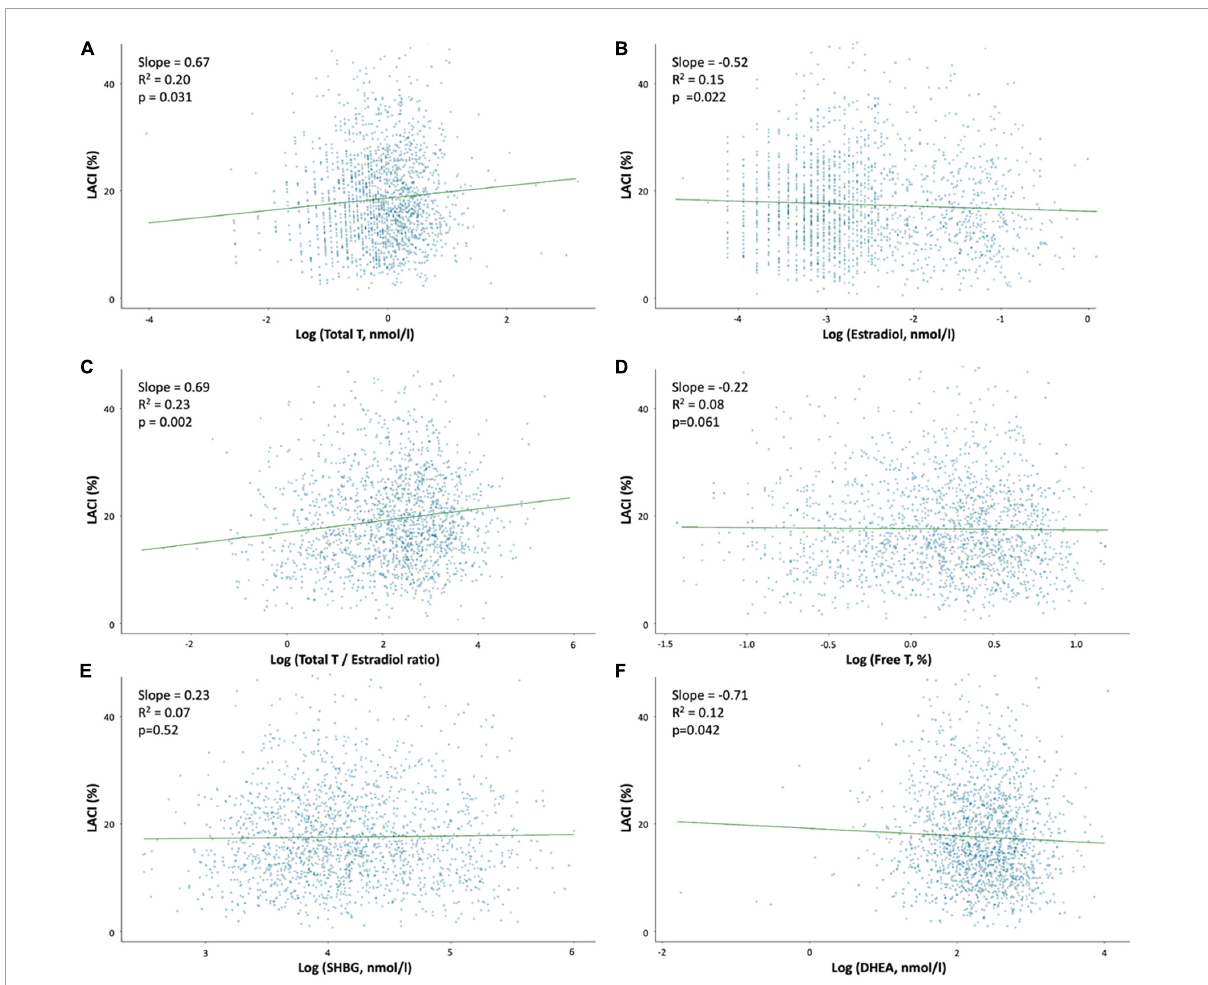
FIGURE3 Association between the LACI value at baseline and sex hormone levels. Regression plot between LACI and log sex hormone levels in the overall population after adjustments for age, ethnicity, systolic blood pressure and diabetes mellitus. (A) Log (Total T, nmol/l); (B) Log (Estradiol, nmol/l); (C) Log (Testosterone/Estradiol ratio); (D) Log (Free T, nmol/l); (E) Log (SHBG, nmol/l); and (F) Log (DHEA,